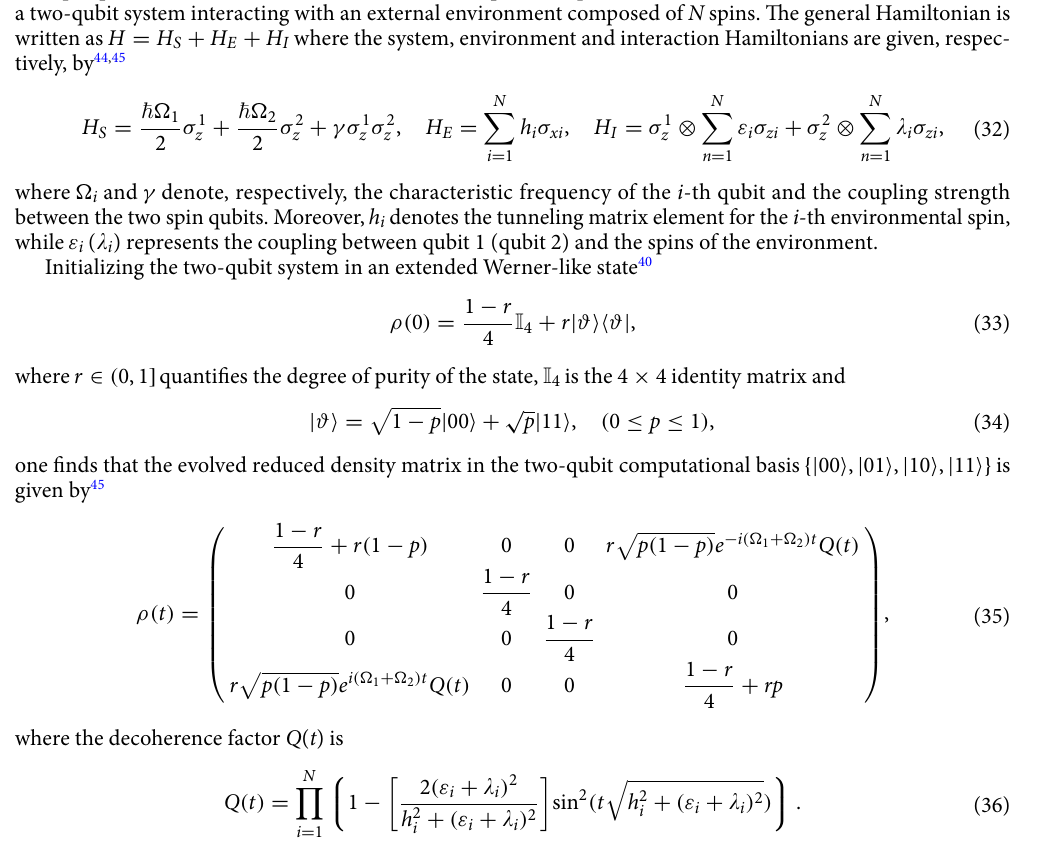
8 . Notice that F ϕ ( t ) approximately 0.3 and R = =